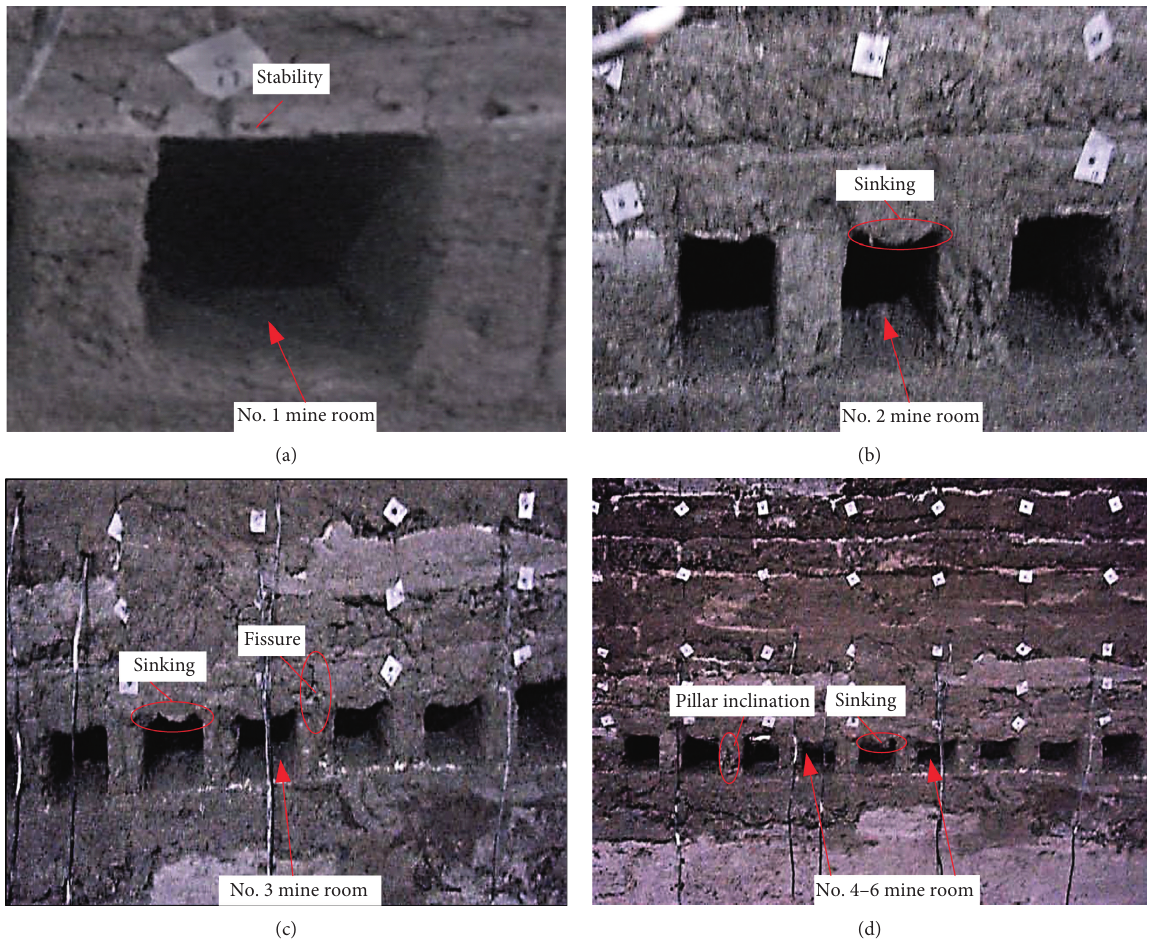
Figure 11: Deformation and failure characteristics of the roof for the 8m ore pillars: (a) first step; (b) second step; (c) third step; (d) fourth